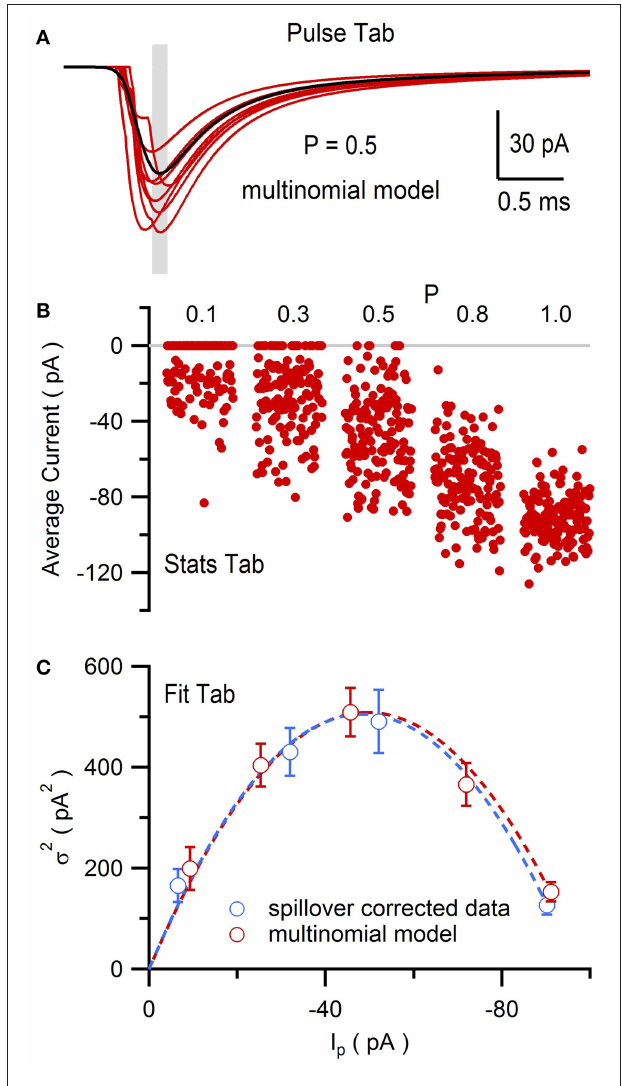
FIGURE 12 | Multiple-probability fluctuation analysis of simulated EPSCs generated by NeuroMatic’s Pulse tab. Multinomial model of a MF-GC synapse as described in Figure 11 . (A) Eight superimposed simulated synaptic AMPAR currents (red) from a total of 150. Gray shaded region denotes the 0.1ms Stats window centered on the peak of the average of all 150 traces (black) used to compute the peak amplitude ( I p ). P = 0.5 for each site. (B) I p for P = 0.1, 0.3, 0.5, 0.8 and 1.0. There were 150 trials for each P . (C) σ 2 I − I p relation (red circles) computed from data in (B) with its fit to Equation (2) (red line; N = 5.3 ± 0.4 and Q p = − 16.8 ± 1.1pA, CV QI ≡ 0.36, CV QII ≡ 0.30, where ≡ denotes fixed fit values). Spillover-corrected experimental data (blue circles) and fit (blue line) are from Figure 10F for comparison.